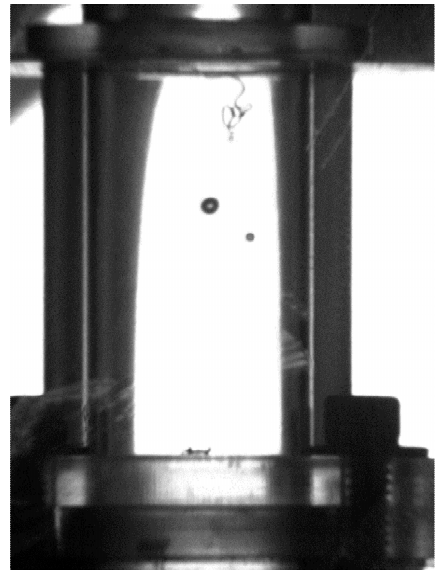
Figure 2. CH 4 bubble (about 1.5 mm in diameter) in pure water at temperature of 288 K.